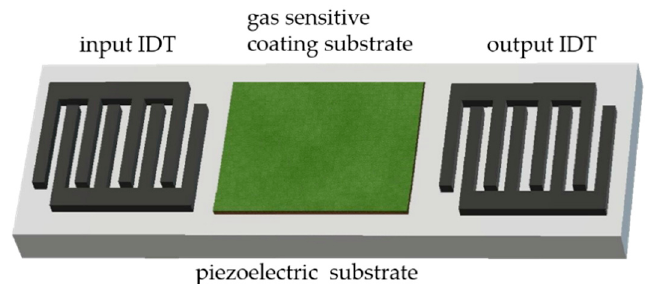
Figure 3. A brief configuration of SAW sensor. The coating substrate can be of polymer, MOS, MOF, nanocomposites and nanocomposites and others.